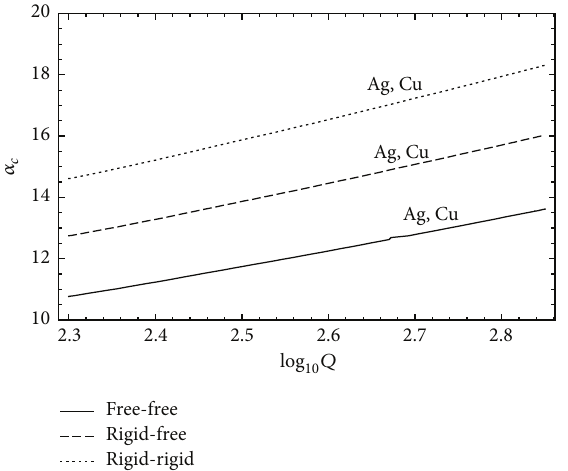
Figure 5: Plot of 𝛼 𝑐 with Chandrasekhar number for fixed Dr = 0.01 and 𝜀 = 0.4 .